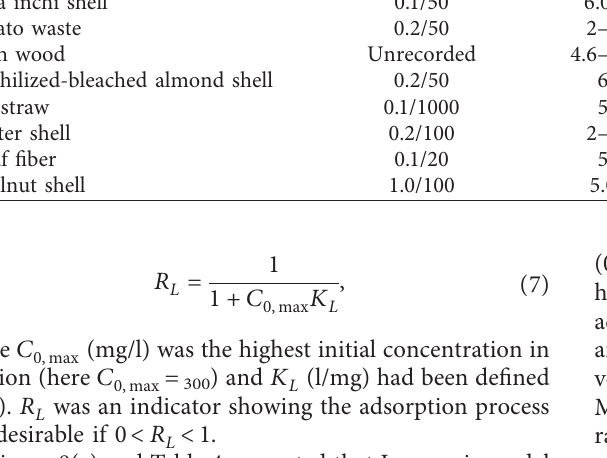
Table 5: The comparison of absorption capacity for Cu(II) by PACs and other biomaterials. Biomaterials